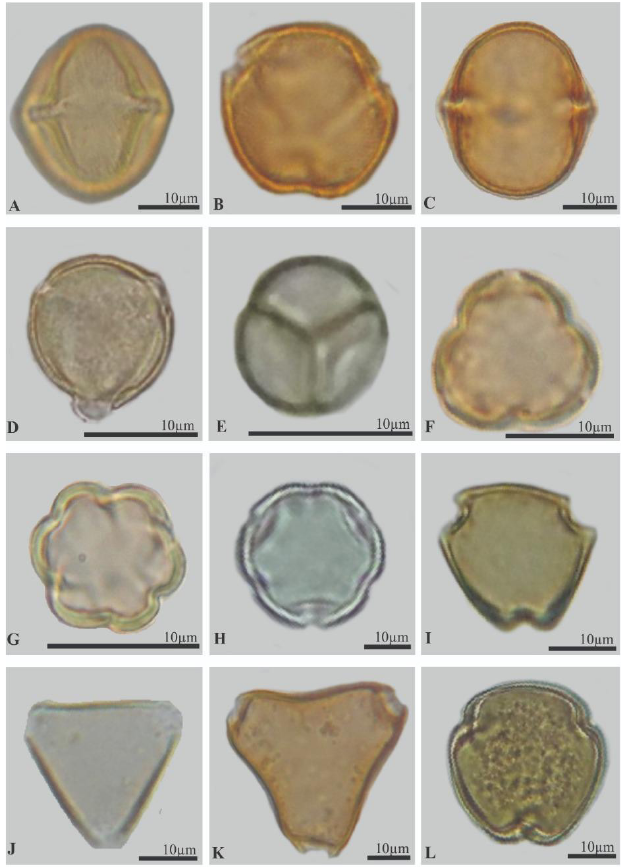
Fig 1 . Photomicrographs of the most frequent pollen types found in honey samples of Melipona seminigra pernigra. Anacardiaceae, Spondias mombin (A) and Tapirira guianensis (B); Burseraceae, Protium heptaphyllum (C); Fabaceae, Dialium (D) and Mimosa pudica (E); Melastomataceae, Bellucia (F), Miconia (G) and Mouriri (H); Myrtaceae, Eugenia (I) and Myrcia (J); Sapindaceae, Talisia (K); Solanaceae, Solanum